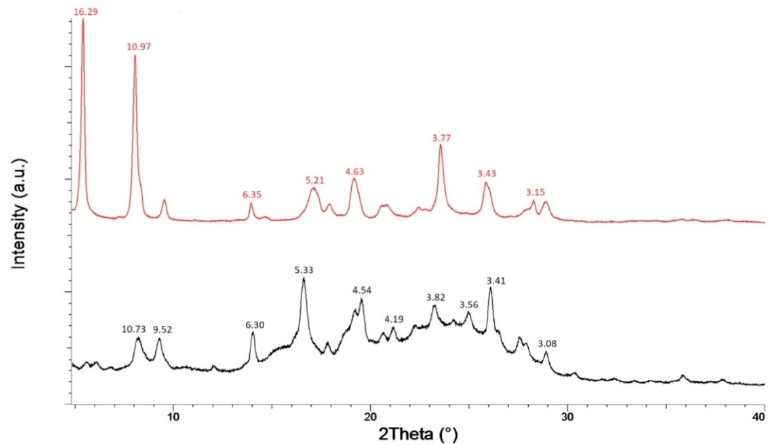
Figure 2. PXRD patterns of CT before (black line) and after (red line) slurry process. Position of the main peaks reported in Å. CT = (+)-catechin.